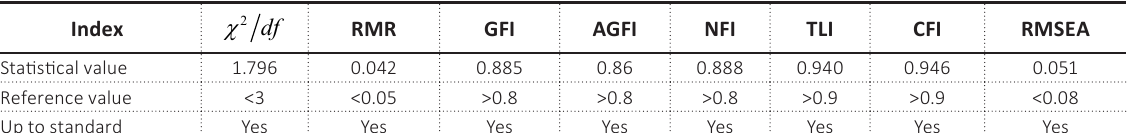
Table 7. Model fit index